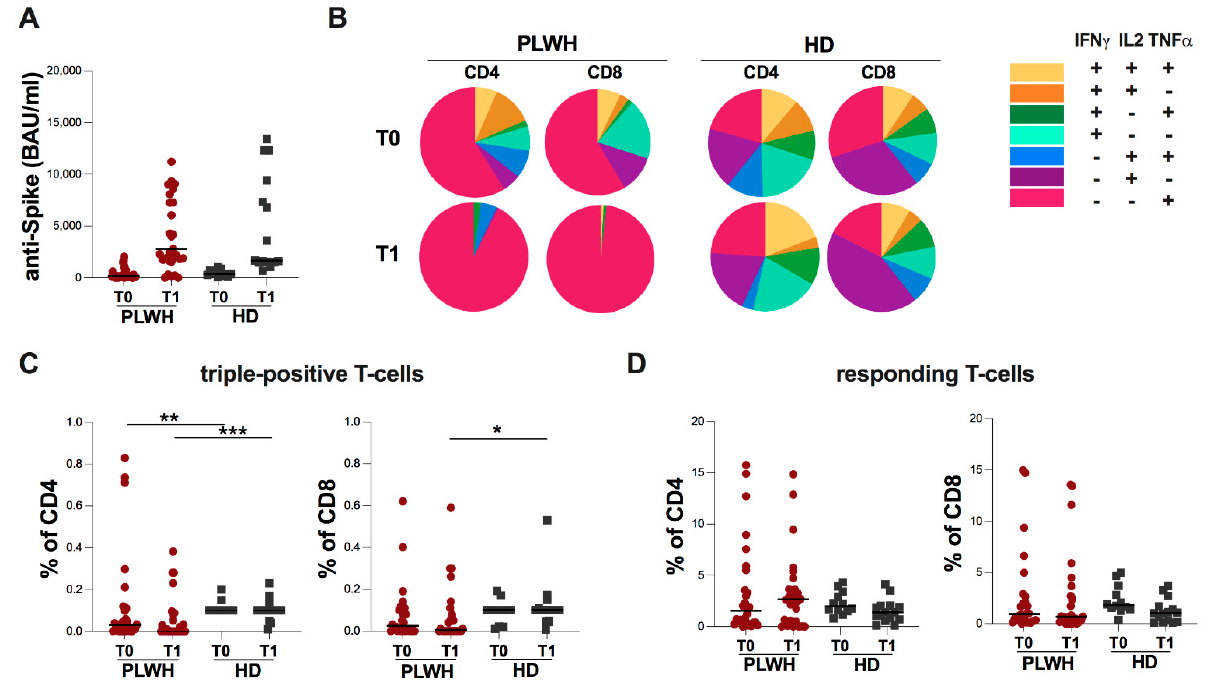
Figure 1. Evaluation of S-specific humoral and T-cell response in PLWH and HD at T0 and T1. ( A ) Anti − S antibody levels in PLWH and HD. For each time point, the differences between the two groups were evaluated using the nonparametric Mann − Whitney test. Data are shown as median (lines). ( B ) Pie charts representing multifunctional cytokine analysis of specific T − cells in PLWH and HD. ( C ) Percentage of triple − positive T-cells in PLWH and HD. The differences were evaluated using the nonparametric Mann − Whitney test. Data are shown as median (lines). ( D ) Percentage of responding T − cells in PLWH and HD. The differences were evaluated using the nonparametric Mann − Whitney test. Data are shown as median (lines). Statistical significance (p ) is reported in the graphics. *** p < 0.001; ** p < 0.01; * p < 0.05.